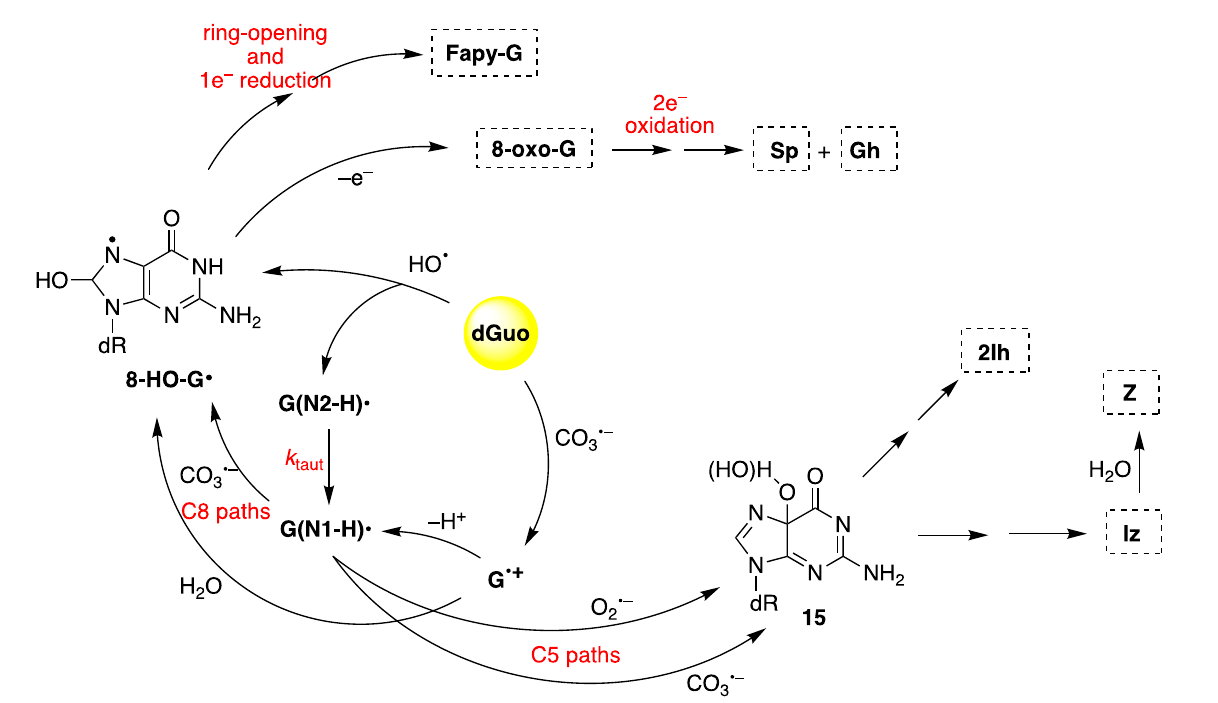
Figure 8. The mechanism of dGuo ( 1 ) oxidation by hydroxyl radical (HO • ) or carbonate radical anion (CO 3• − ); for the chemical structures of 8-oxo-G, Fapy-G, Sp, Gh, 2Ih, Iz, and Z, see Figure 15.